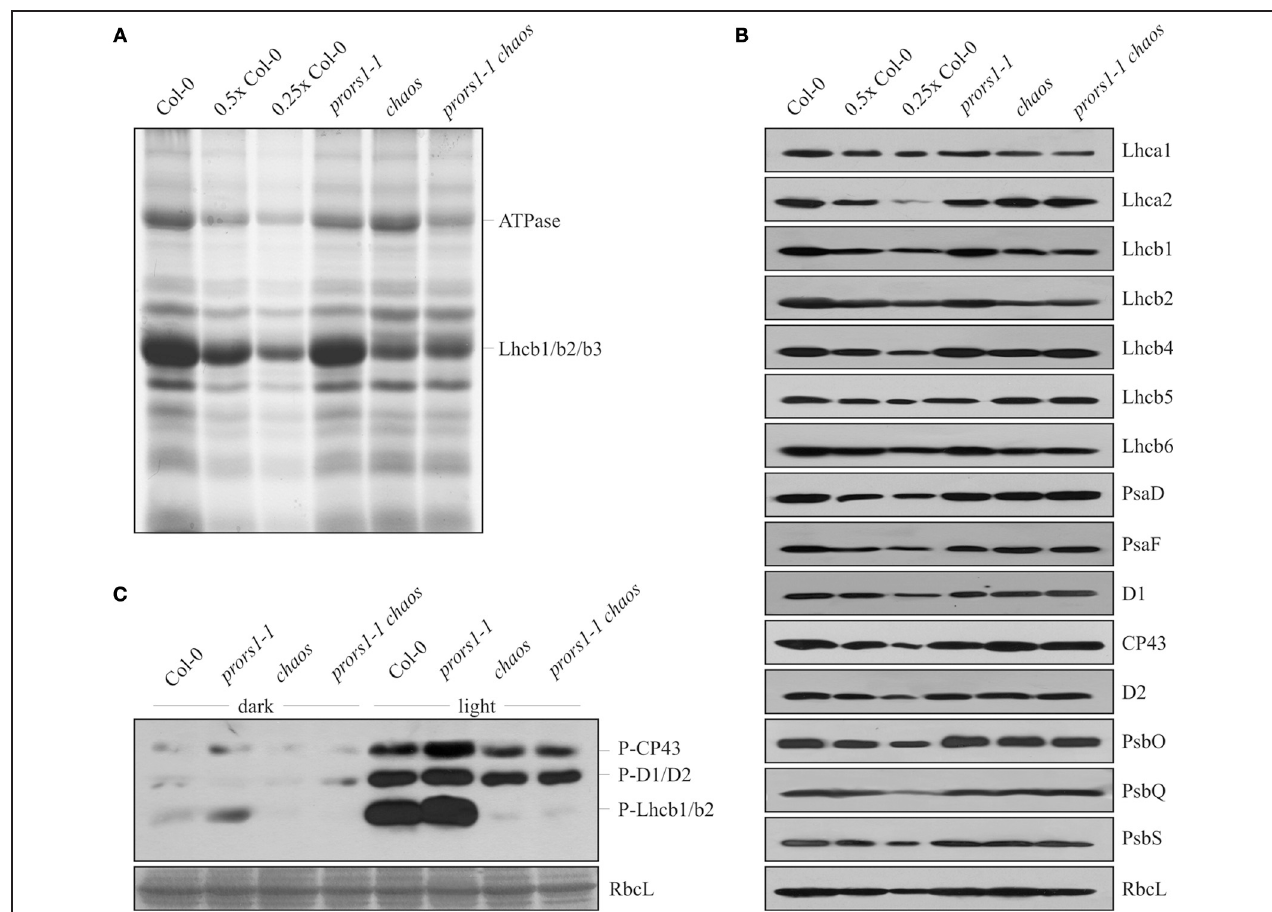
FIGURE 3 | 1D SDS-PAGE and immunoblot analysis of thylakoid proteins from WT (Col-0) and mutant ( prors1-1 , chaos, and prors1-1 chaos ) leaves. (A) Thylakoid proteins isolated from equal amounts of leaf (fresh weight) were fractionated by SDS-PAGE and stained with Coomassie Brilliant blue. Band intensities were quantified by densitometric analyses (see “Materials and Methods”). (B) Identical amounts of total leaf proteins were fractionated by SDS-PAGEs as in (A) , transferred onto nylon filters and probed with antibodies raised against individual subunits of PSI (PsaD, PsaF), PSII (D1, CP43, D2, PsbO, PsbQ,